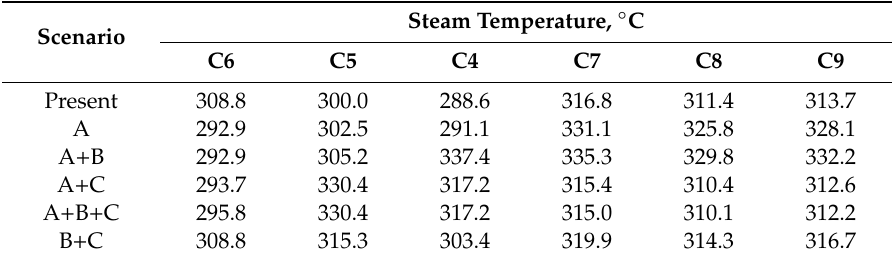
Table 10. Temperature of HPS at selected units after changes within the HPS steam network. Steam Temperature, ◦ Scenario